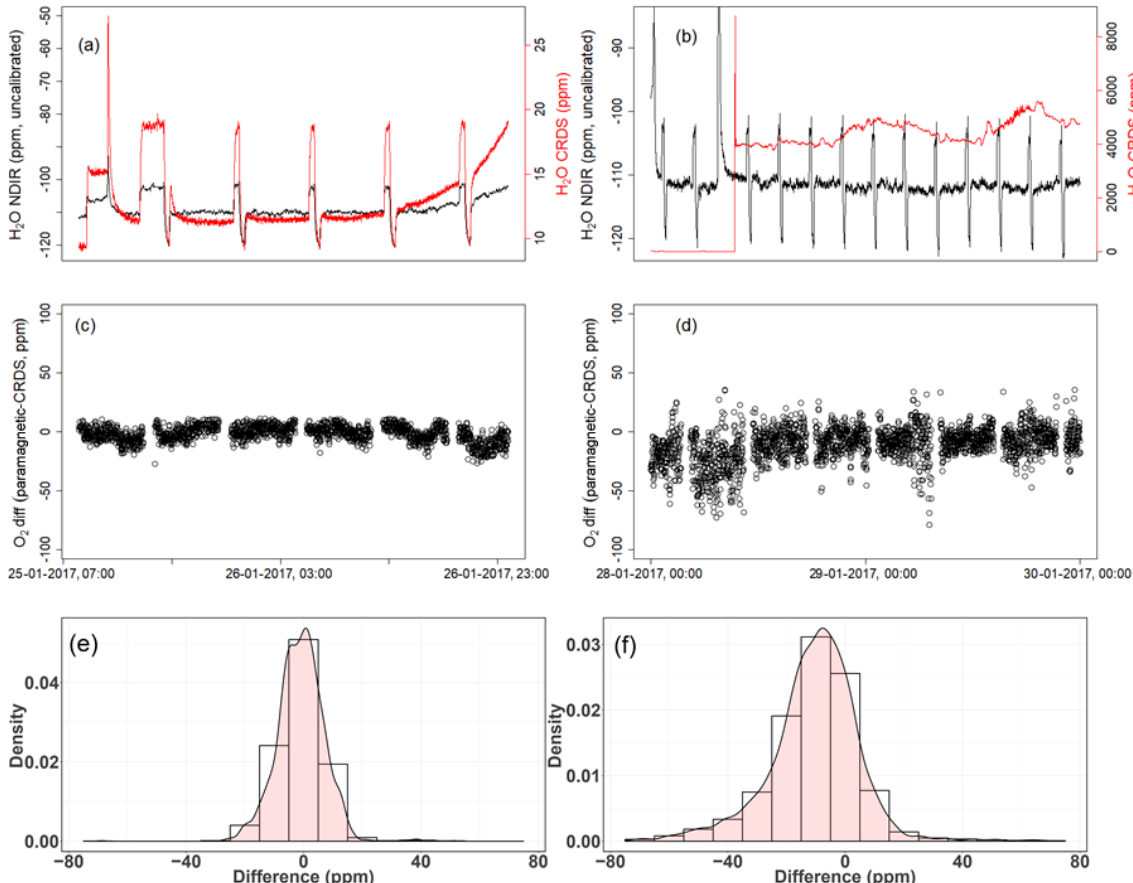
Figure 15. Results of water correction tests. Water measurements of the NDIR (left axis) for dry conditions (a, b) and the CRDS analyzer (right axis) for dry (a) and wet (b) conditions. The difference in oxygen measurements between the paramagnetic and the CRDS instrument using the built-in water correction for the CRDS values under dry (c) and wet (d) conditions. Panels (e) and (f) show the population density